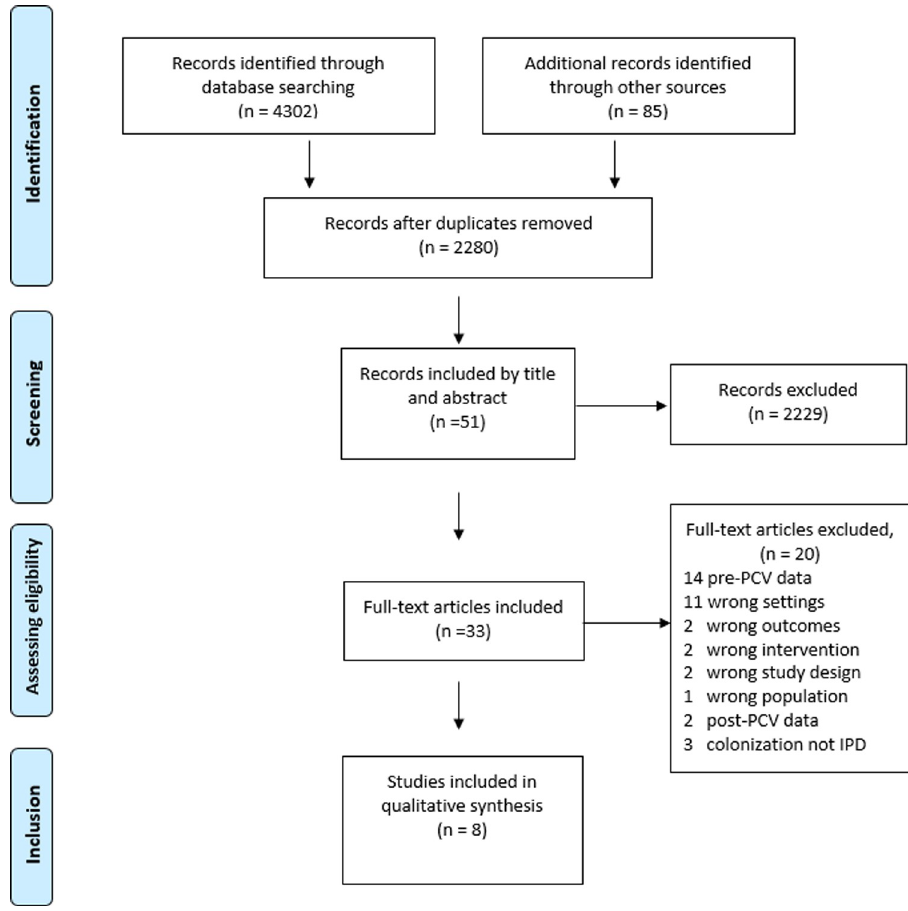
Fig 1. Study selection